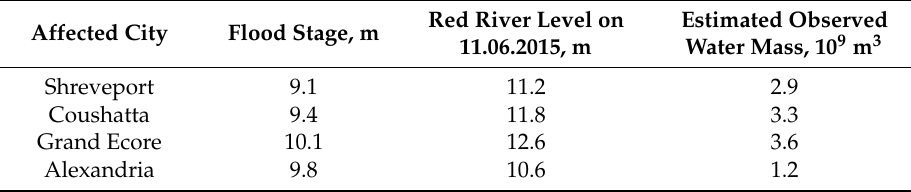
Table 3. The Louisiana flood observed water mass calculation.